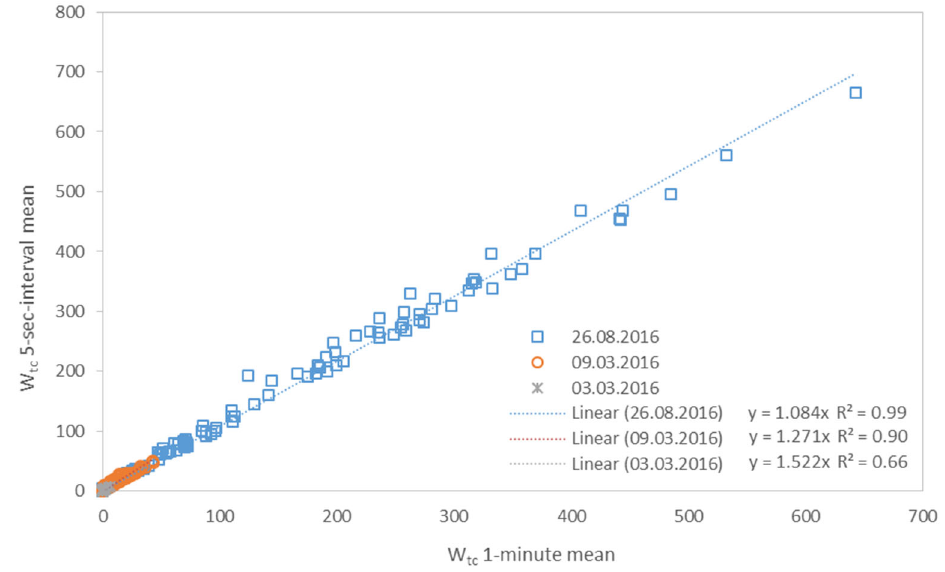
Figure 5. Comparison of the transport capacities of the wind derived from 1 min averages of wind velocity and from the 5 s intervals .